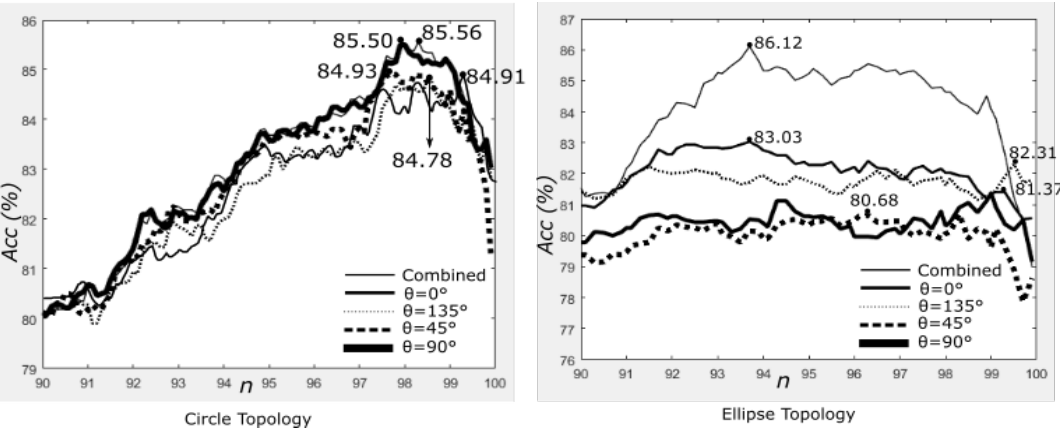
Figure 16. Quantitative results using different orientations evaluated on the MIAS dataset [18]. Note that the x- axis and y- axis represent the accuracy (percentage of correctly classified cases) and the percentage of dominant patterns,